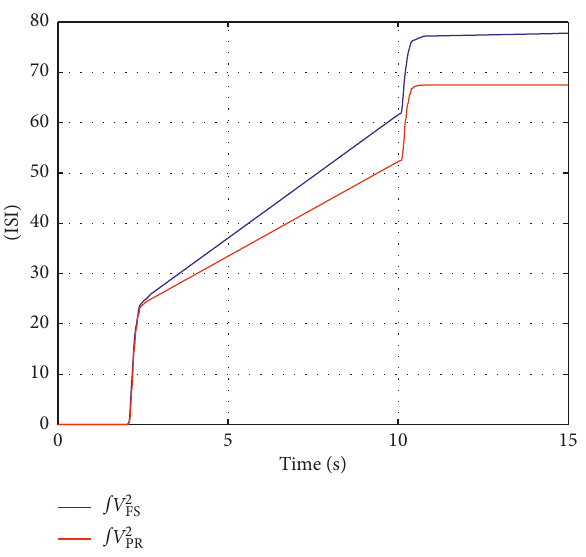
Figure 10: Performance index of the controller.